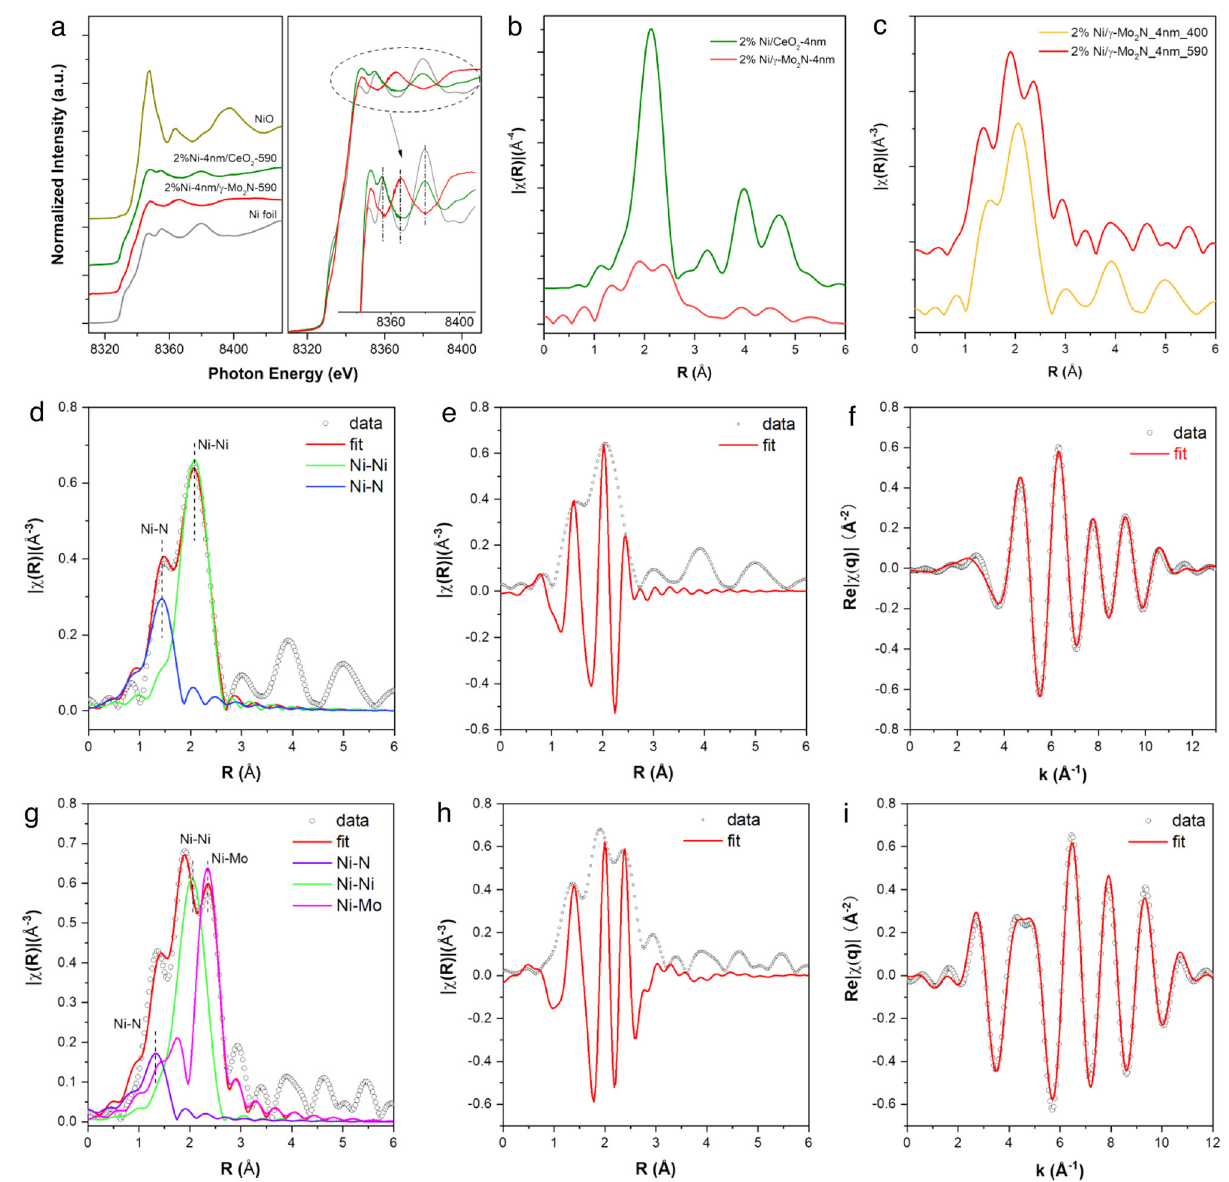
Fig. 4 In-situ XAFS characterizations of 2%Ni-4nm/ γ -Mo 2 N catalyst treated at different temperatures of 400 and 590 °C in the atmosphere of H 2 /N 2 at a ratio of 3:1. a The evolution of Ni feature of Ni-4nm/ γ -Mo 2 N and Ni-4nm/CeO 2 from Ni K edge XANES, and the detailed comparison of XANES is presented at the right panel; The EXAFS fi gures at R space of b 2%Ni-4nm/ γ -Mo 2 N-590 and 2%Ni-4nm/CeO 2 -590, and c 2%Ni-4nm/ γ -Mo 2 N-400